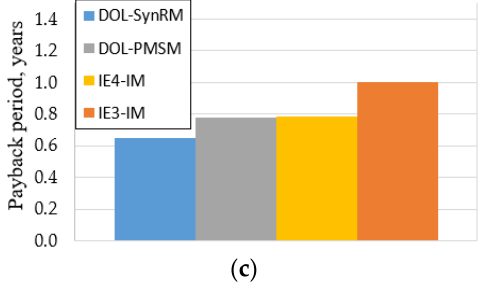
Figure 12. Payback period of various motor types (the case of replacing the motor in an exploiting pump unit): ( a ) case 1 (without cable and transformer losses); ( b ) case 2 (3 pump units considering the cable losses); ( c ) case 3 (3 pump units considering the cable and transformer losses).